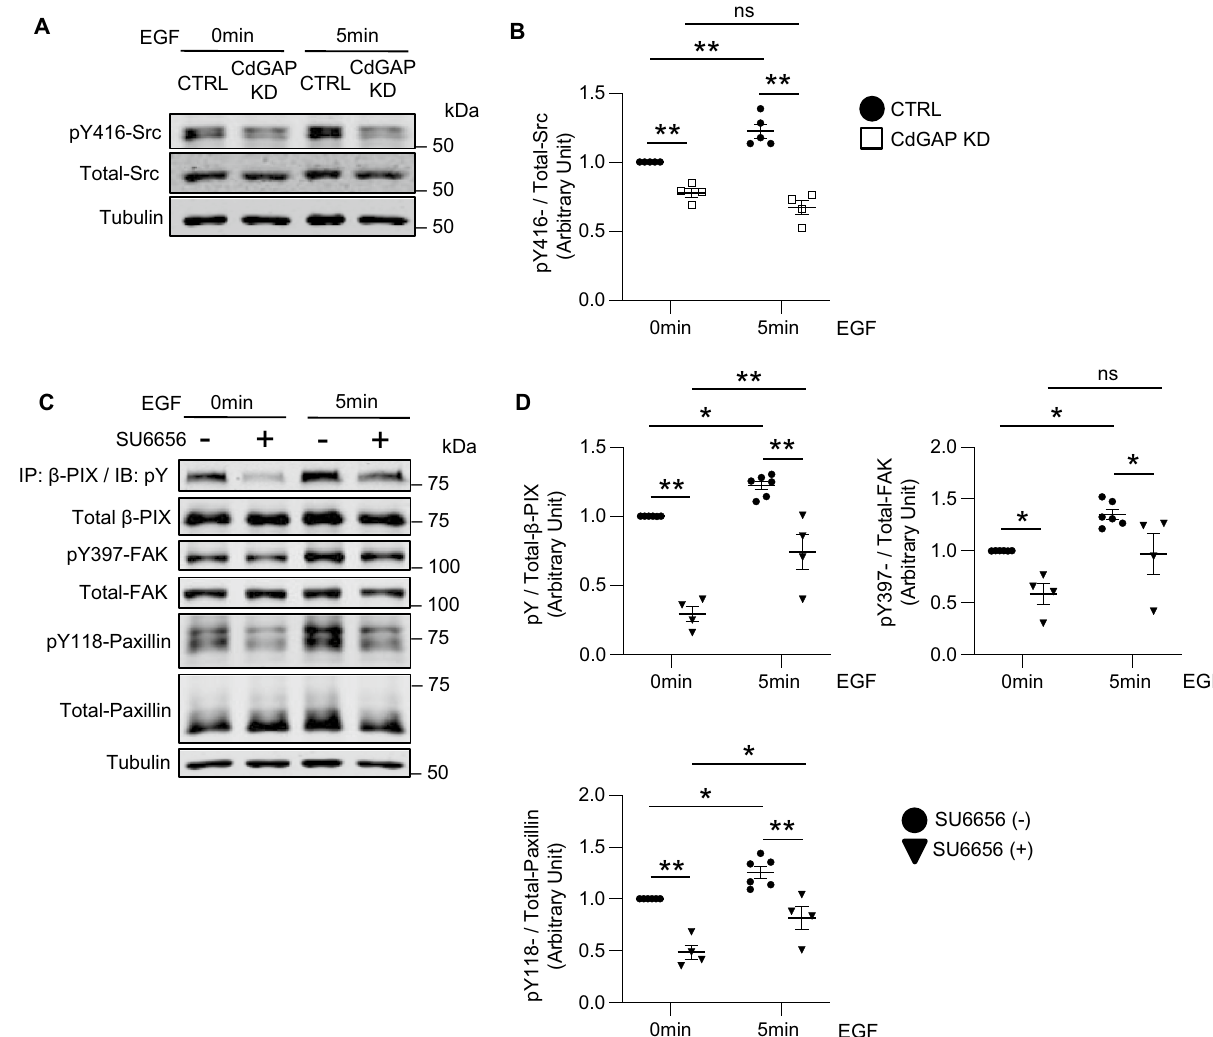
Figure 6. CdGAP is required for EGF-induced Src kinase activity in podocytes. ( A ) Representative immunoblots for pY416 and total Src using CdGAP KD and control (CTRL) podocytes treated with EGF (100 ng/ml). ( B ) Densitometric quantification of pY416 Src normalized to total Src in ( A ). ( C ) Representative immunoblots for pY- and total β-PIX, FAK and paxillin using CTRL podocytes. Cells were treated with vehicle or 5 µM Src inhibitor, SU6656 for 16 h before EGF stimulation. ( D ) Densitometric quantification of pY-β-PIX, pY397-FAK and pY118-paxillin normalized to total expression in ( C ). n = 4 or 5 ( B ); 4 or 6 ( D ) in each group. Statistically significant differences (* P < 0.05, ** P < 0.01), assessed by ANOVA with the Tukey–Kramer test ( B,D ), are